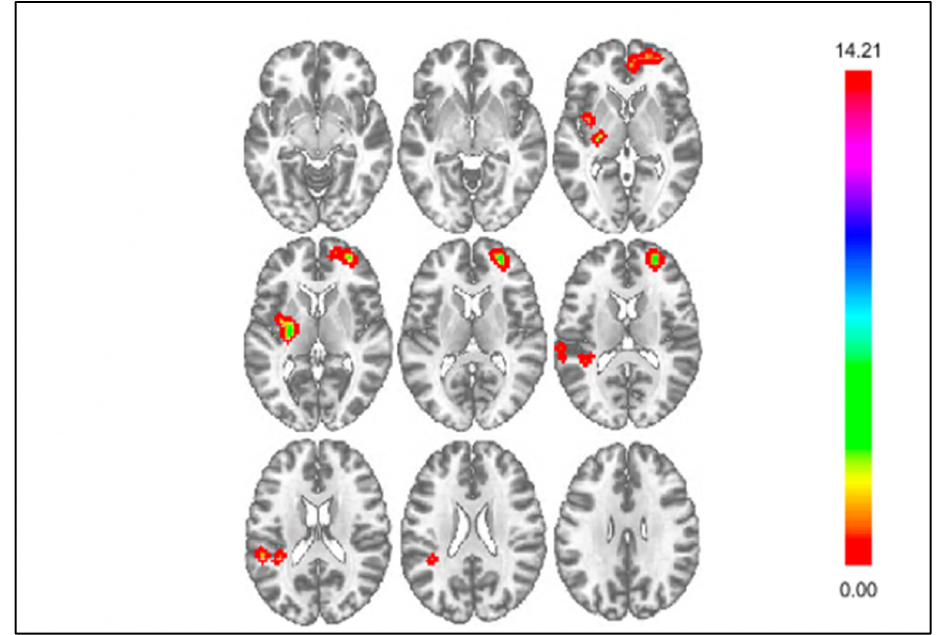
Figure 3. Whole brain results showing significant clusters for connectivity with the DS seed for negative outcomes, loss > control. Table 3. Whole-brain connectivity results: Differences between youth with and without NSSI.